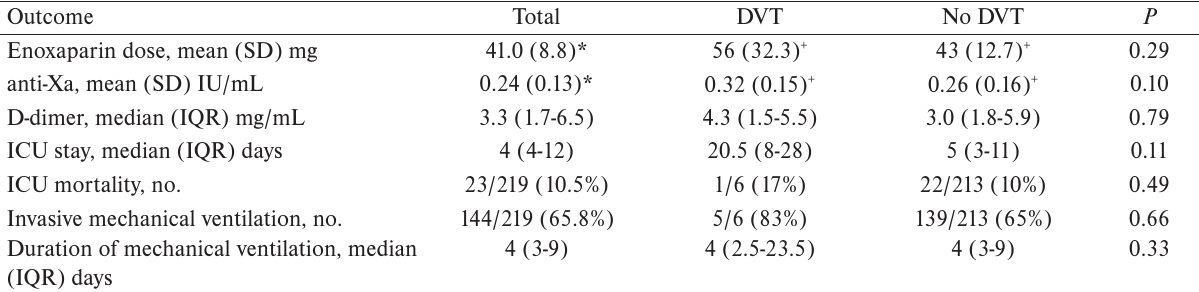
Table 3. Outcomes ICU.